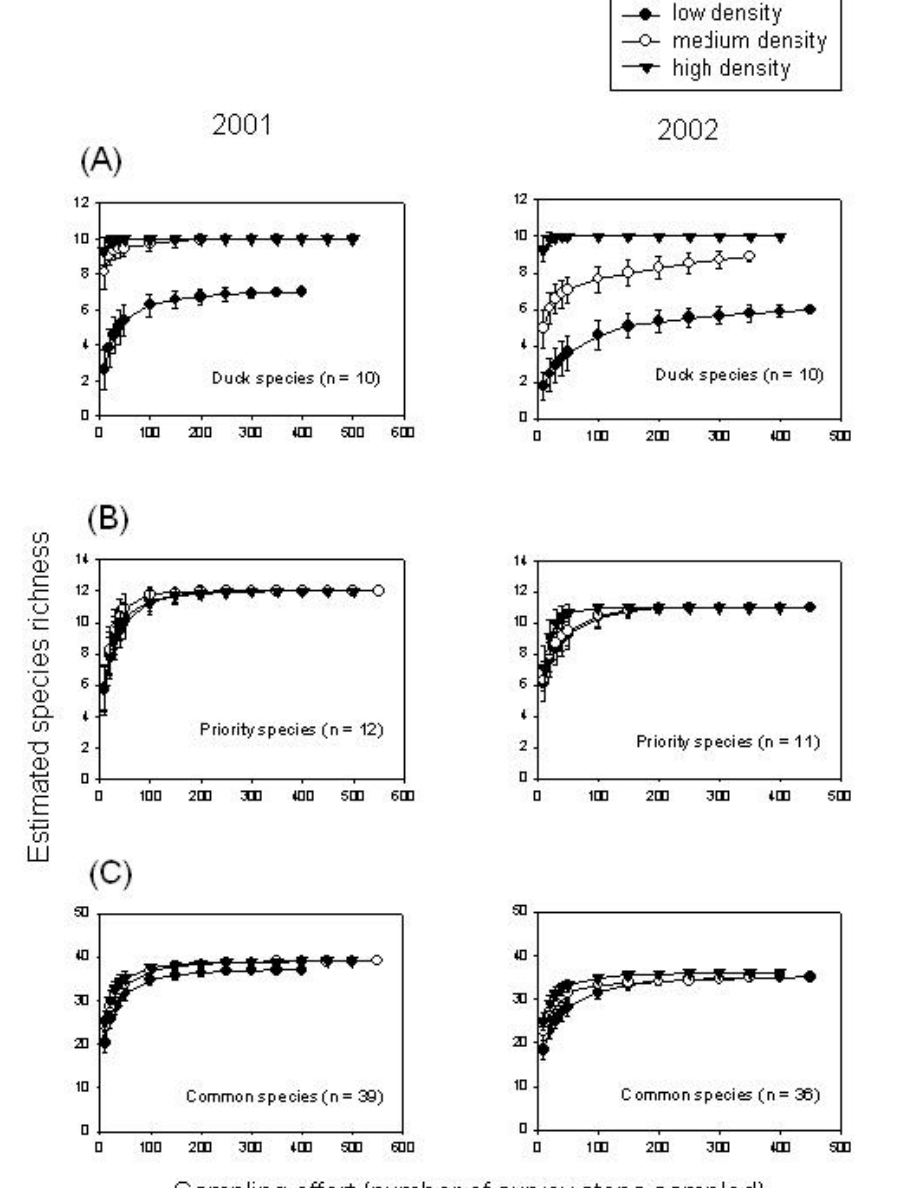
Fig. 3. Rarefaction curves for three key groups of grassland bird species encountered along point transect routes in southern Saskatchewan in 2001 and 2002: (A) duck species, (B) priority grassland bird species, and (C) common grassland bird species. Curves indicate the estimated sample species richness (± SD) detected with increasing numbers of survey stop points along routes in low (< 8 pairs/km²), medium (8–15 pairs/km²), and high (> 15 pairs/km²) predicted waterfowl density strata, indicated by symbols. Note that the scale of the y-axis differs among bird